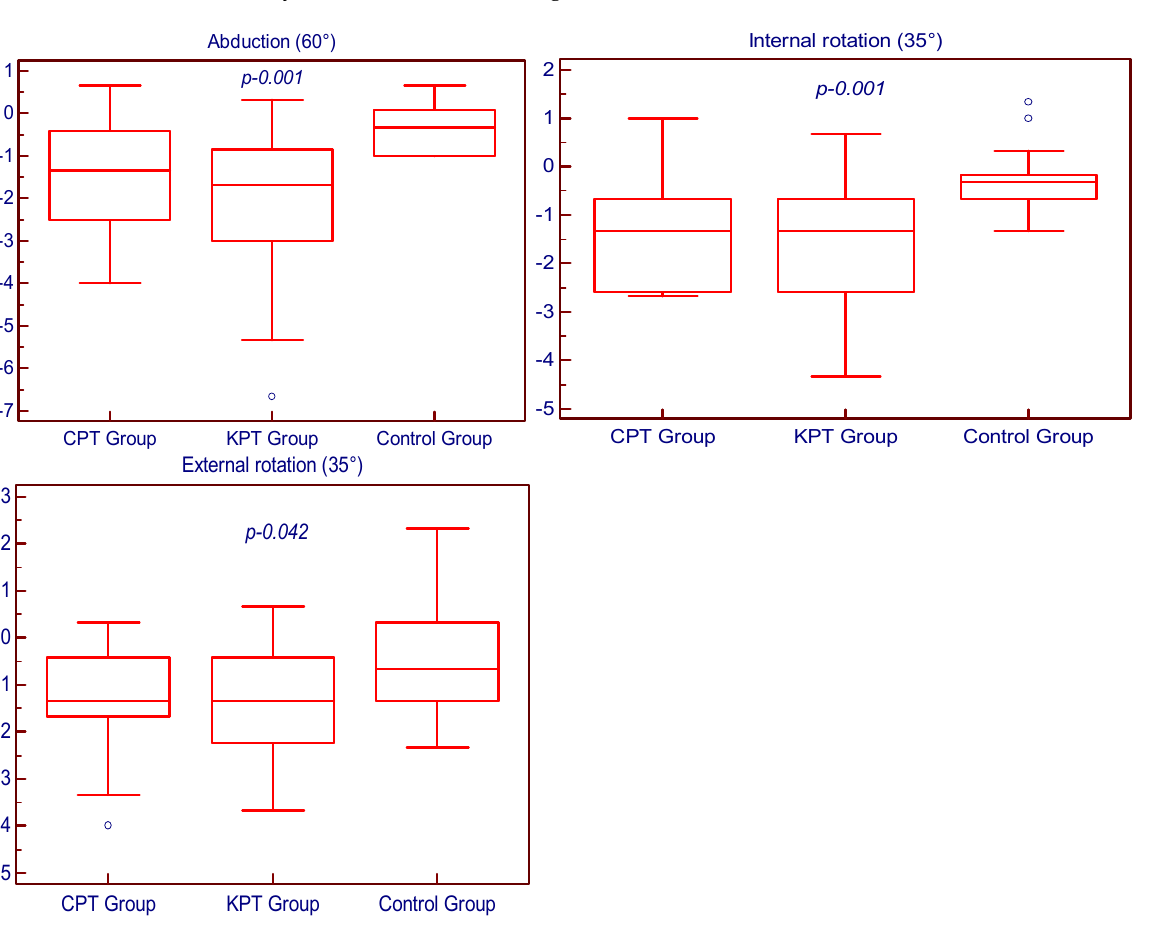
Table 4. Intra–group comparative analysis of the DASH Outcome Questionnaire.